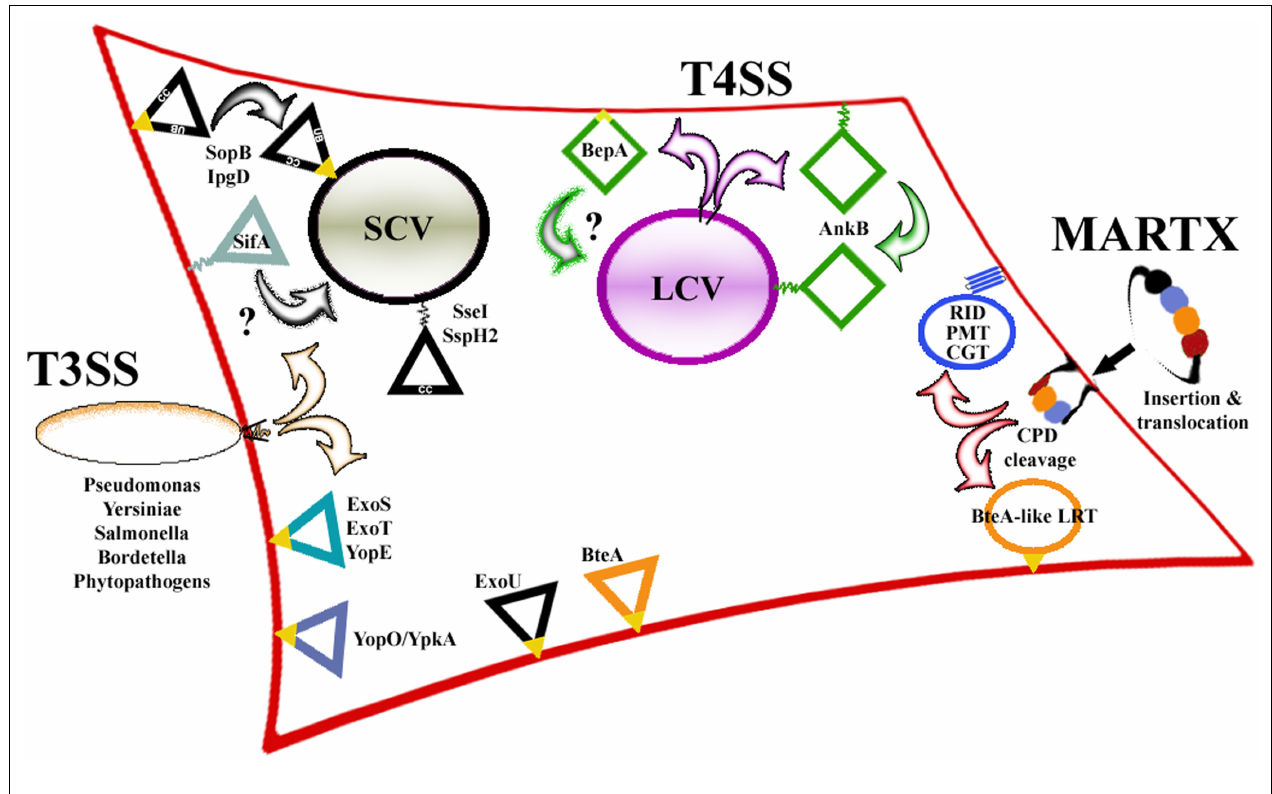
(triangles,T3SS; squares,T4SS; circles, MARTX). Potential hydrophobic interactions with the membrane are indicated as yellow patches on the effector. CC, coiled-coil domain; UB, ubiquitination site; SCV, Salmonella -containing vacuole; LCV, Legionella -containing vacuole. See text for